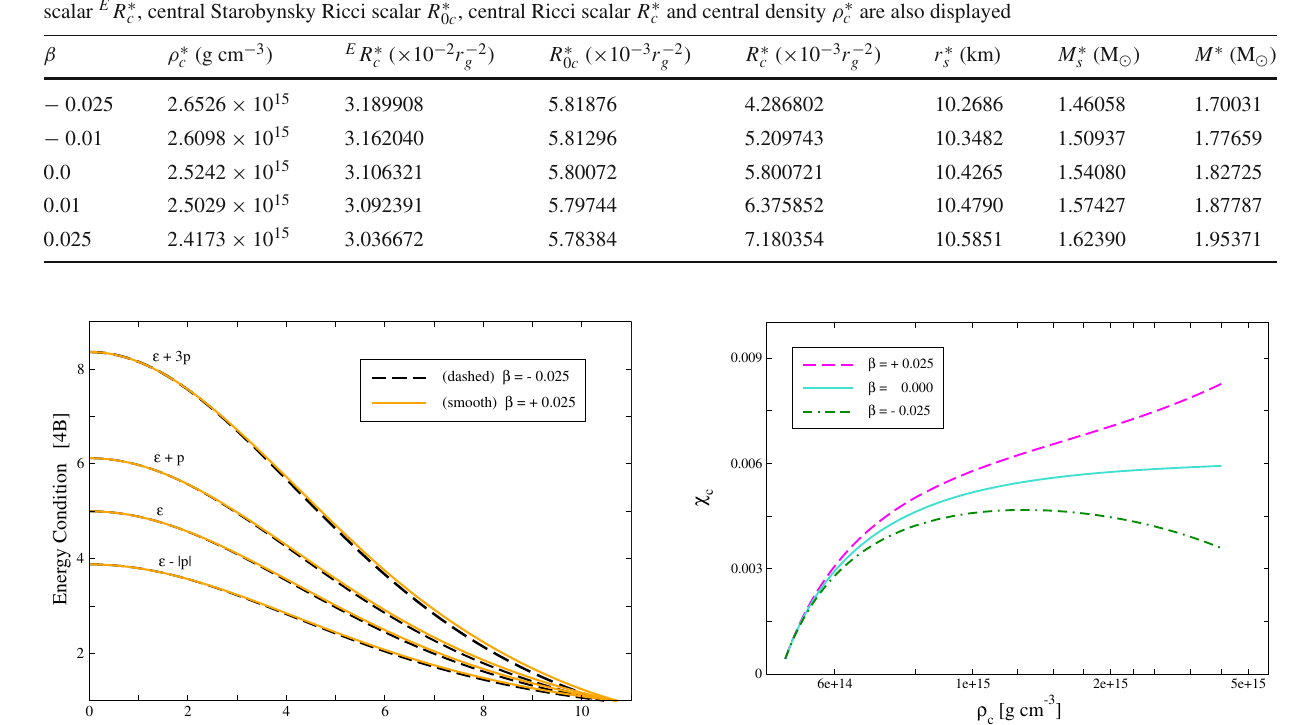
ρ ∗ c . The inset shows that